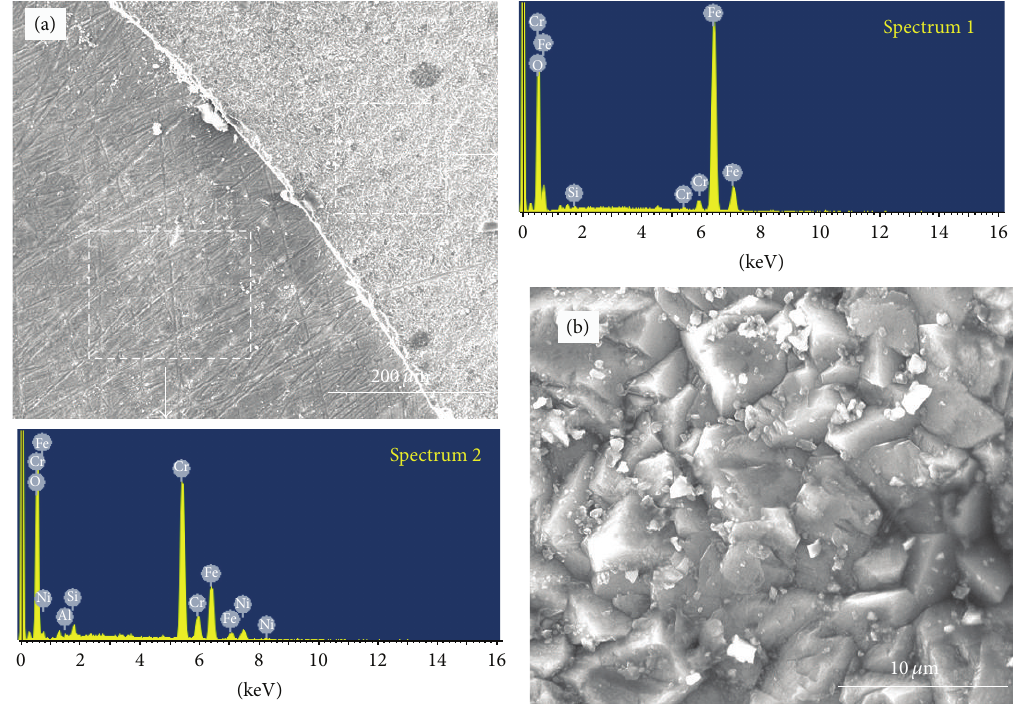
Figure 8: Surface morphology and EDX of the corrosion products on SS304 after 120 h of immersion in molten carbonate at 650 ∘ C. (a) is the overview of the region where the outermost layer was partly spalled off and (b) is the enlarged view of the outermost layer.